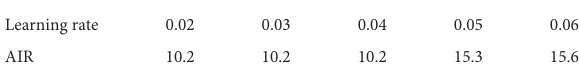
TABLE6 The effect of learningrateon average inhibition rate(AIR) (%).